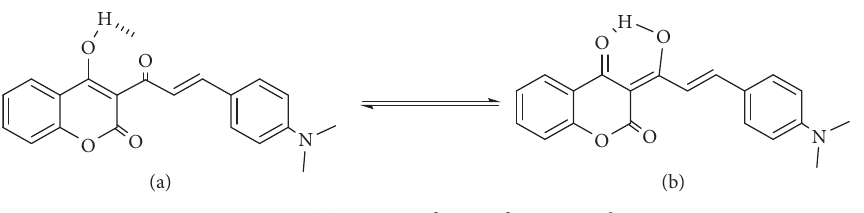
Scheme 3: Tautomeric forms of compound 3 . Table 1: Results of in vitro tests of the antimicrobial activities of coumarin derivatives 1 and 3. Bacteria